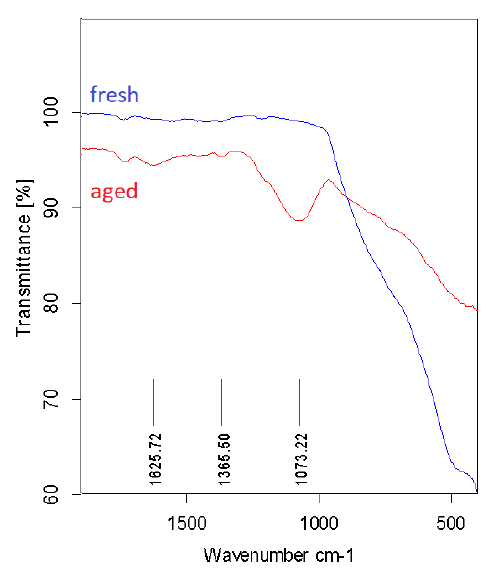
Figure 9. FTIR-ATR spectra of the vehicle-aged and fresh diesel oxidation catalysts.